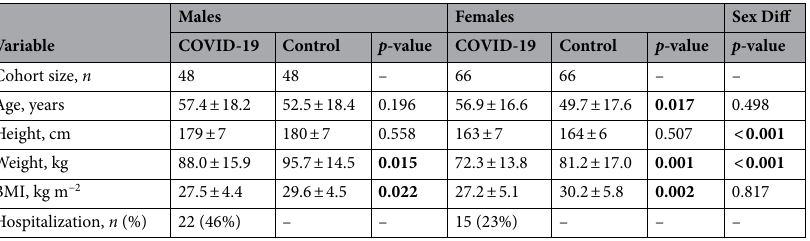
Table 1. Patient demographics. Data are reported as count or mean ± standard deviation (SD). Data are compared using one-way analysis of variance. p -values are reported for between group comparisons (COVID- 19 vs. control) for males and females separately, and between sex comparisons (males vs. females) for both groups pooled. BMI, body mass index. Significant values are in